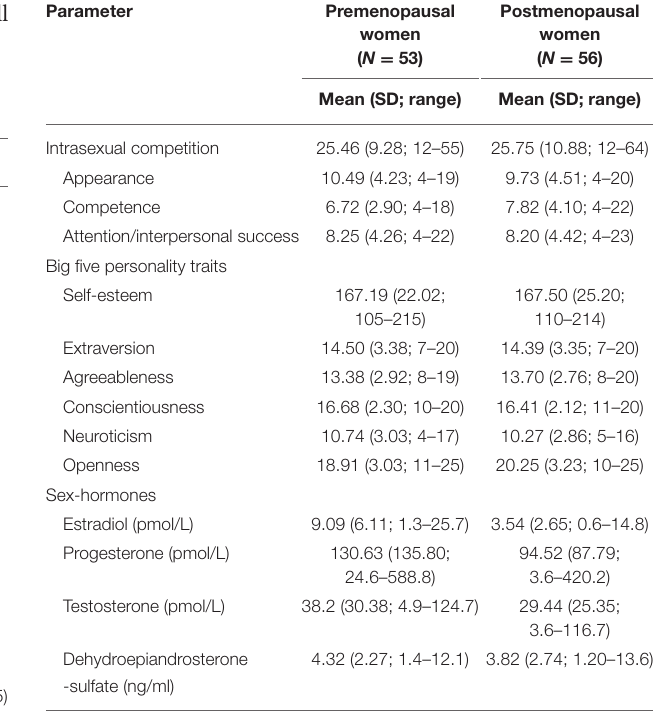
TABLE 2 | Descriptive statistics for pre- and postmenopausal